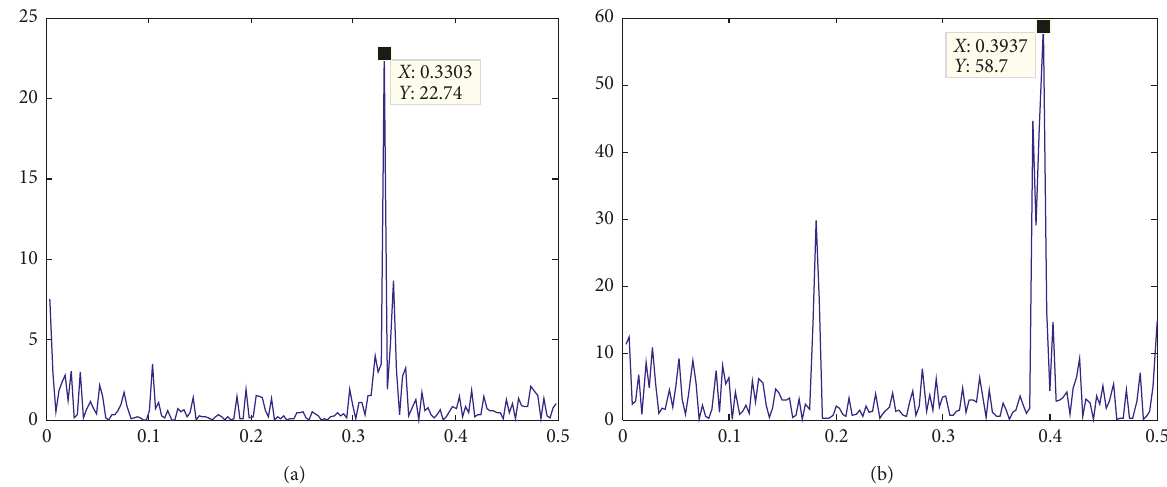
Figure 14: FFTdistribution of frequencies for models with an ice thickness of 0.5D at 10.5m/s for (a) CM1 ( θ � 0 ° ) and (b) CM2 ( θ � 30 ° ).